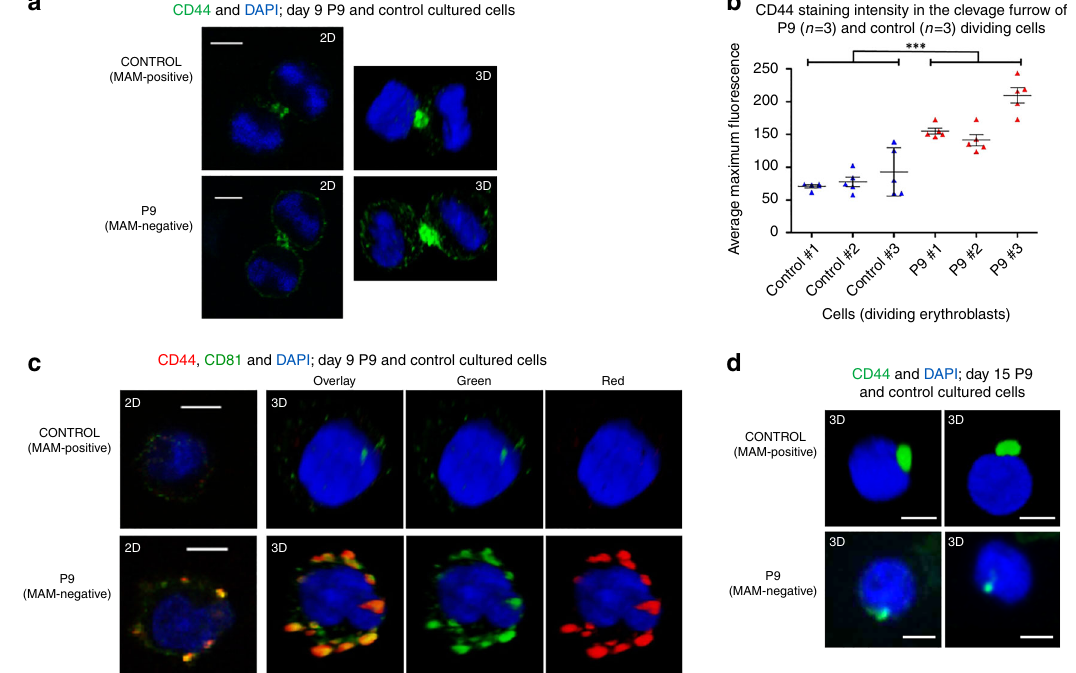
Fig. 6 Confocal microscope analysis of MAM-negative P9, MAM-positive control erythroblasts and enucleating erythroblasts cultured as described in Supplementary Fig. 6. Control MAM-positive and P9 MAM-negative erythroblasts were harvested on day 9 and 15, fi xed in 1% (wt/vol) paraformaldehyde, permeabilised with 0.05% (wt/vol) saponin and stained for the presence of CD44 and tetraspanin CD81. Nuclei were stained with DAPI (blue). Representative cells shown from approximately 10 micrographs per sampling day. a Dividing erythroblasts were stained with anti-CD44 (green) and shown in 2D and 3D. Scale bars are 5 µ m. b Average CD44 staining intensities ( n = 5 independent measurements from each dividing cell) of three P9 and three control dividing cells were obtained with Leica LAS AF software. MAM-negative samples showed signi fi cantly larger maximum fl uorescence in the cleavage furrows than the control samples (two-tailed t test; d f = 28, P = 1.14 × 10 − 8 ). Data are presented as mean values, with error bars representing standard deviation. Source data are provided as a Source Data fi le. c Erythroblasts stained with anti-CD44 (red) and anti-CD81 (green). Shown in 2D and 3D. Scale bars are 5 µ m. d Representative free nuclei stained with anti-CD44 (green) showing CD44 to be associated with free nuclei after enucleation in the fi nal stages of erythrocyte maturation. Shown in 3D. Scale bars are 5 µ human primary antibodies (in-house IBGRL reference collection), or polyclonal rabbit anti-mouse immunoglobulin G (IgG; Dako) for mouse primary monoclonal antibodies (IBGRL Research Products and Japanese Red Cross). Anti-MAM eluates were prepared using Gamma ELU-KIT ™ II rapid acid elution kit (Immucor). Agglutination was scored on a scale of 0 (negative) to 5 + (strongest positive). For testing with monoclonal anti-EMP3, RBCs from P8, P9 and two MAM- positive controls were papain treated, followed by PGNaseF treatment and then tested in parallel with anti-MAM and monoclonal anti-EMP3 (clone 439949; R&D Systems). The papain + PNGaseF (two-stage) treated cells were also tested with anti-Rh (BRIC69; IBGRL Research Products) and anti-RhAG (LA1818; IBGRL Research Products) to check the treatment ef fi cacy and speci fi city. For blocking tests, 5 μ l washed, packed, papain + PNGase F (two-stage) treated RBCs were incubated fi rst with 10 μ l human anti-MAM eluate for 1h at 37°C, washed four times, and incubated with mouse monoclonal anti-EMP3 (clone 439949), for 1 h at room temperature, then subjected to an IAT using anti-mouse globulin. An unrelated murine monoclonal antibody anti-Rh (BRIC69) was tested in parallel. An example of human polyclonal anti-Jk b (Lorne Laboratories), was used to sensitise control cells in order to demonstrate speci fi c blocking.